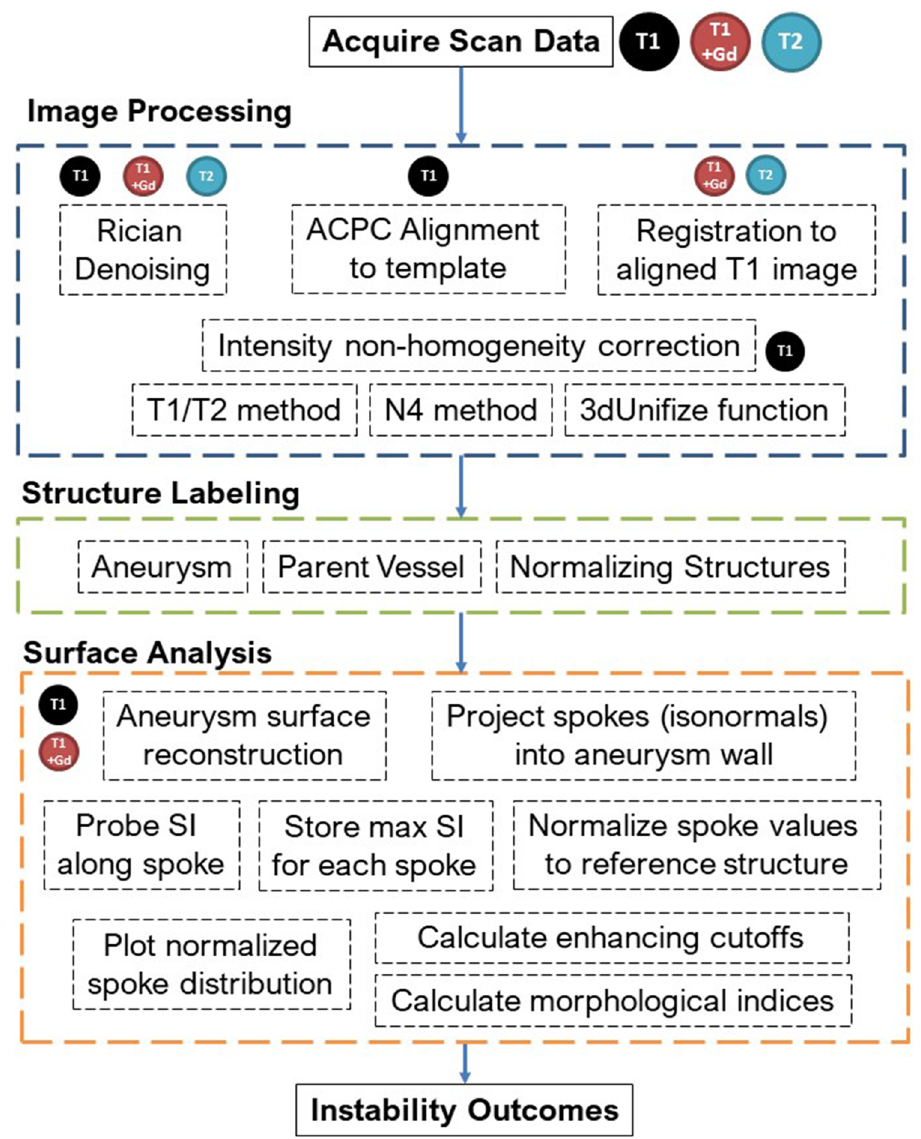
Figure 8. Flow chart depicting semi-automated reconstruction and quantification of AWE from image acquisition to final